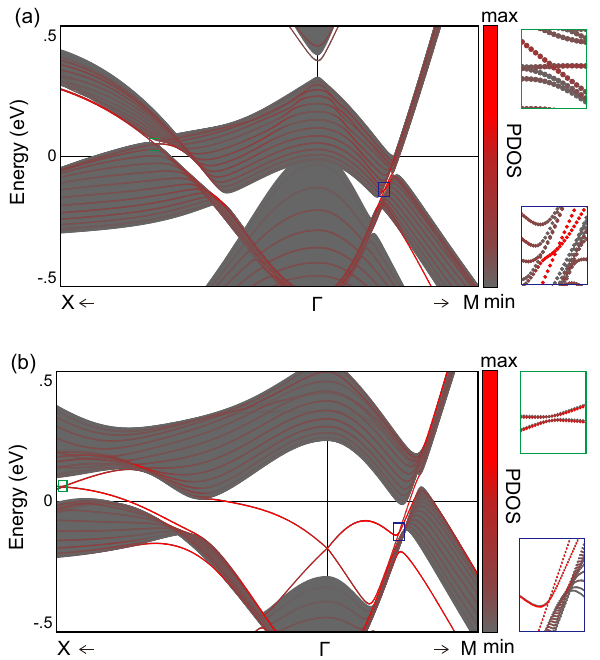
Figure 3. (001) surface energy spectra of NaZnSb 1 x Bi x at ( a ) x = 0.31 and ( b ) x = 1.00. The discrete energy − spectra calculated from a slab geometry are overlapped with the continuous grey bulk projected spectra. The strength of the surface projection is indicated in red; the more substantial the red color, the stronger the localization at the surface. The right panels show the magnified views of the boxed regions in the left panels. The 0.31 ( x band crossing (anticrossing) is shown in the magnified views for the case of x =